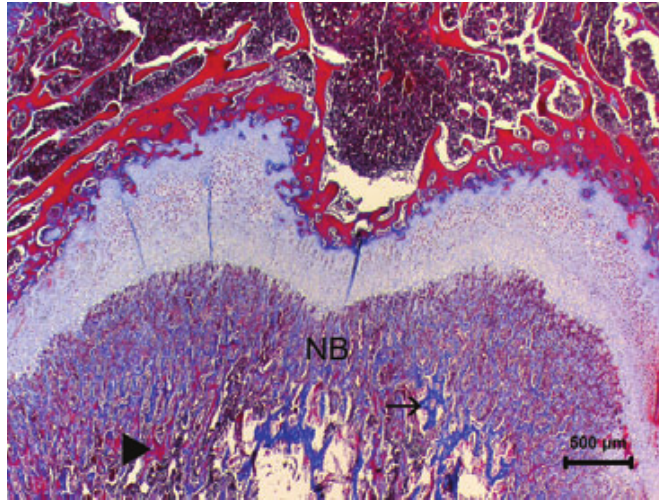
FIGURE 3 – Masson’s trichrome x 25. Photomicrograph of longitudinal section of distal growth plate of the rat femur after 21 days of laser irradiation. New bone (NB), Calcified Bone Matrix (arrow head), Calcified Cartilage Matrix